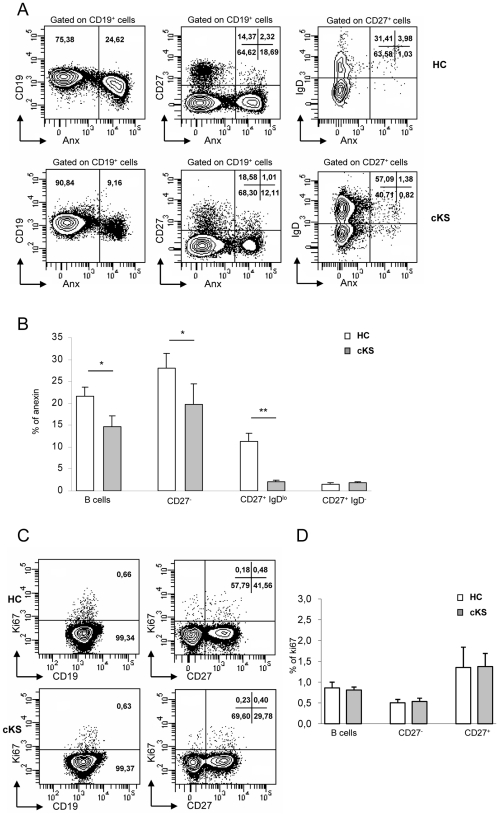
B cells from cKS patients show increased resistance to spontaneous apoptosis and unaffected in vivo turnover.Apoptotic cells were detected by annexin V binding after 24 h culture in unstimulated conditions. A, representative flow cytometric analysis showing annexin V binding gated on total B cells, CD27−, MZ-like (CD27+IgDlo) and switched memory (CD27+IgD−) B cells, as indicated; comparison between one HC (upper row) and one cKS patient (lower row). B, B cells from cKS patients (grey bars) showed significantly lower annexinV binding than B cells from HCs (white bars); this lower annexin V binding was evident on CD27− and MZ-like (CD27+IgDlo) B cells, roughly composing the preimmune/natural effector compartment, but not on antigen-experienced switched memory (CD27+IgD−) B cells. Data shown as mean ± SE. C, In vivo cell turnover was estimated by Ki67 staining of freshly isolated PBMCs. Representative flow cytofluorimetric analysis showing Ki67 binding gated on total B cells, CD27− and CD27+ B cells, as indicated; comparison between one HC (upper row) and one cKS patient (lower row). D, The proportion of Ki67+ cells within total B cells, CD27− and CD27+ B cells did not differ between cKS patients (grey bars) and HCs (white bars). Data shown as mean ± SE. P-values calculated using the Student t test for independent samples.*P<.05; **P<.01.